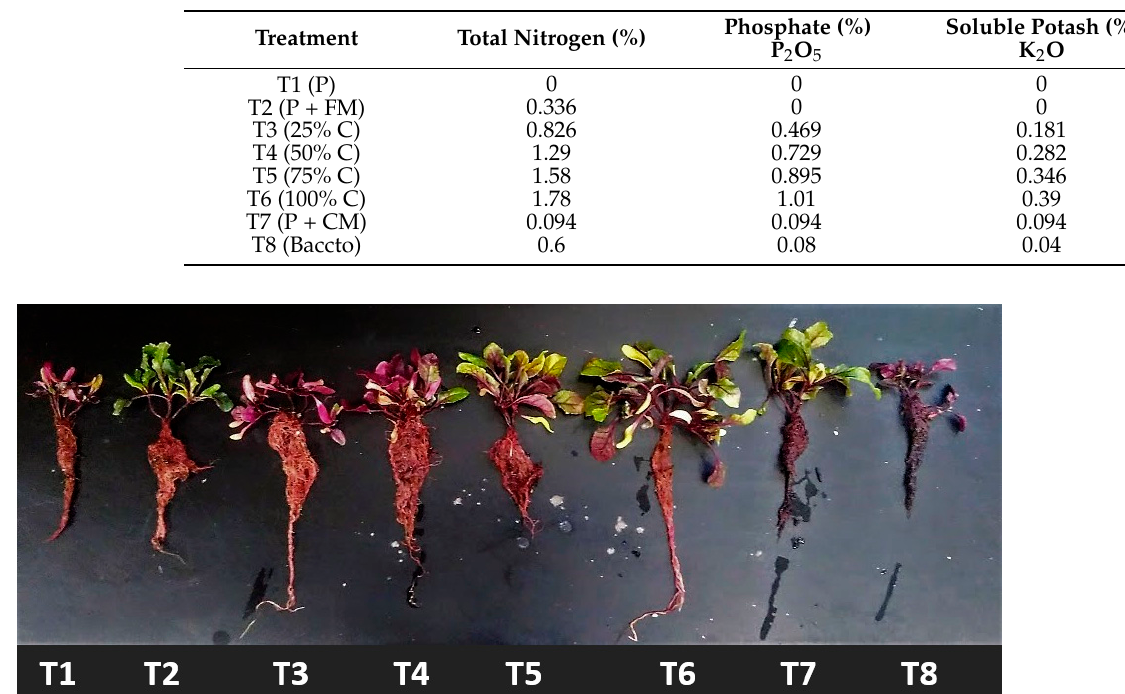
Figure 1. Effect of potting-media treatments on beet seedling growth, 36 days after seeding.